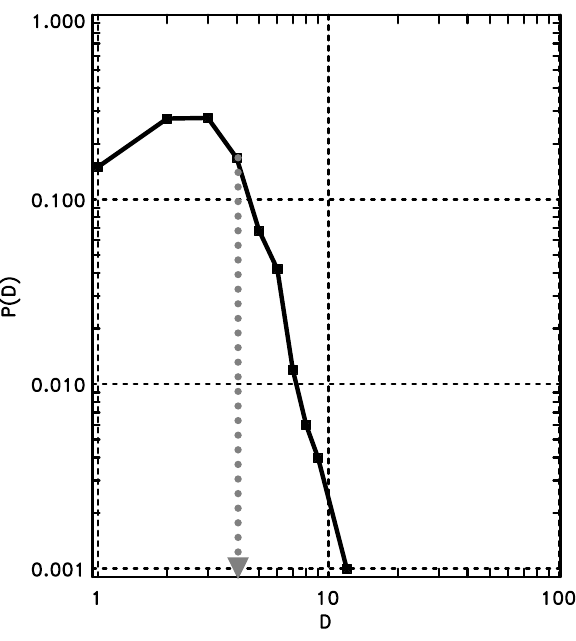
Fig. 4. Distribution functions of D n calculated with NN = 3 and M I = M O = 50 for the time series generated by the synchronized Lorenz attractor. Distribution function drops rapidly to zero around D =